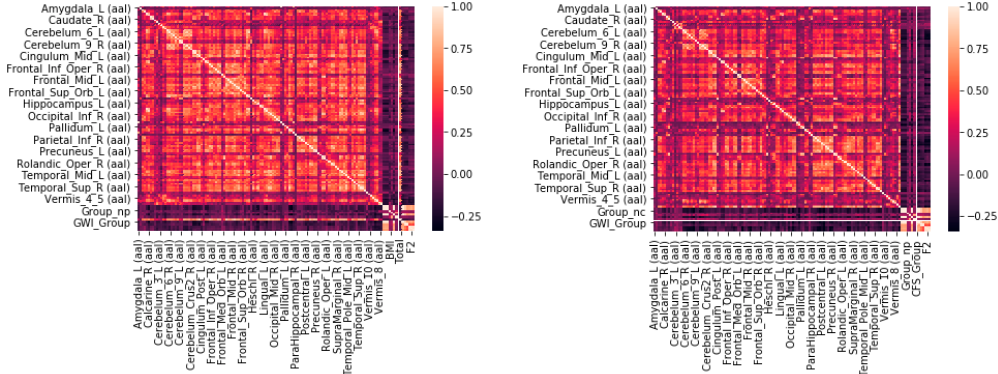
Figure 2. Heatmap of Pearson’s Correlation Coefficients. The numbers of significantly activated voxels ( t > 3.17, p < 0.0001) in each Automated Anatomical Labeling (AAL) region for all subjects were compared on Day 1 (pre-submaximal exercise, left) and Day 2 (post-submaximal exercise, right).